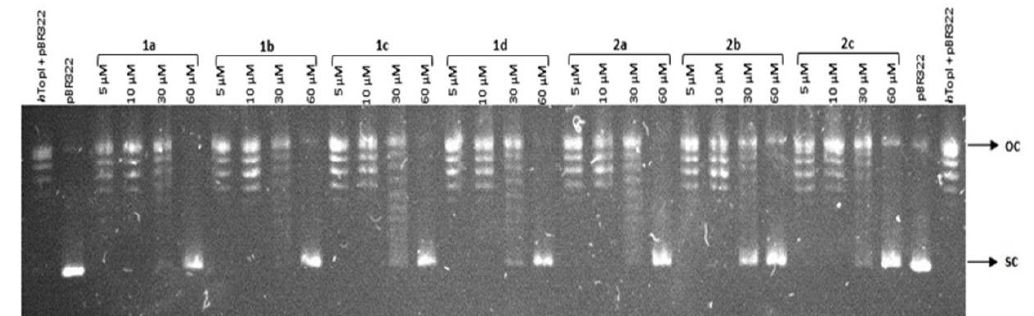
Figure 1. Electrophoresis agarose gel showing inhibitory effects of tacrine-coumarin compounds 1a – 2c on human topoi- somerase I ( h TOPI) activity. Supercoiled plasmid DNA ( p BR322—negative control) was incubated for 30 min with 2 U of h TOPI in the absence (lines h TOPI + p BR322—positive control) and presence of varying concentrations of compounds 1a-2c (lines 1a – 2c ).